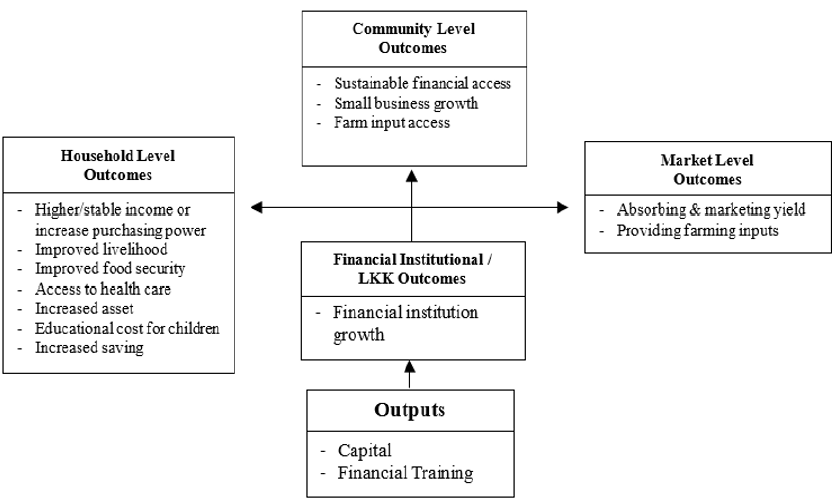
Figure 3. Change dynamics caused by the KMP program.